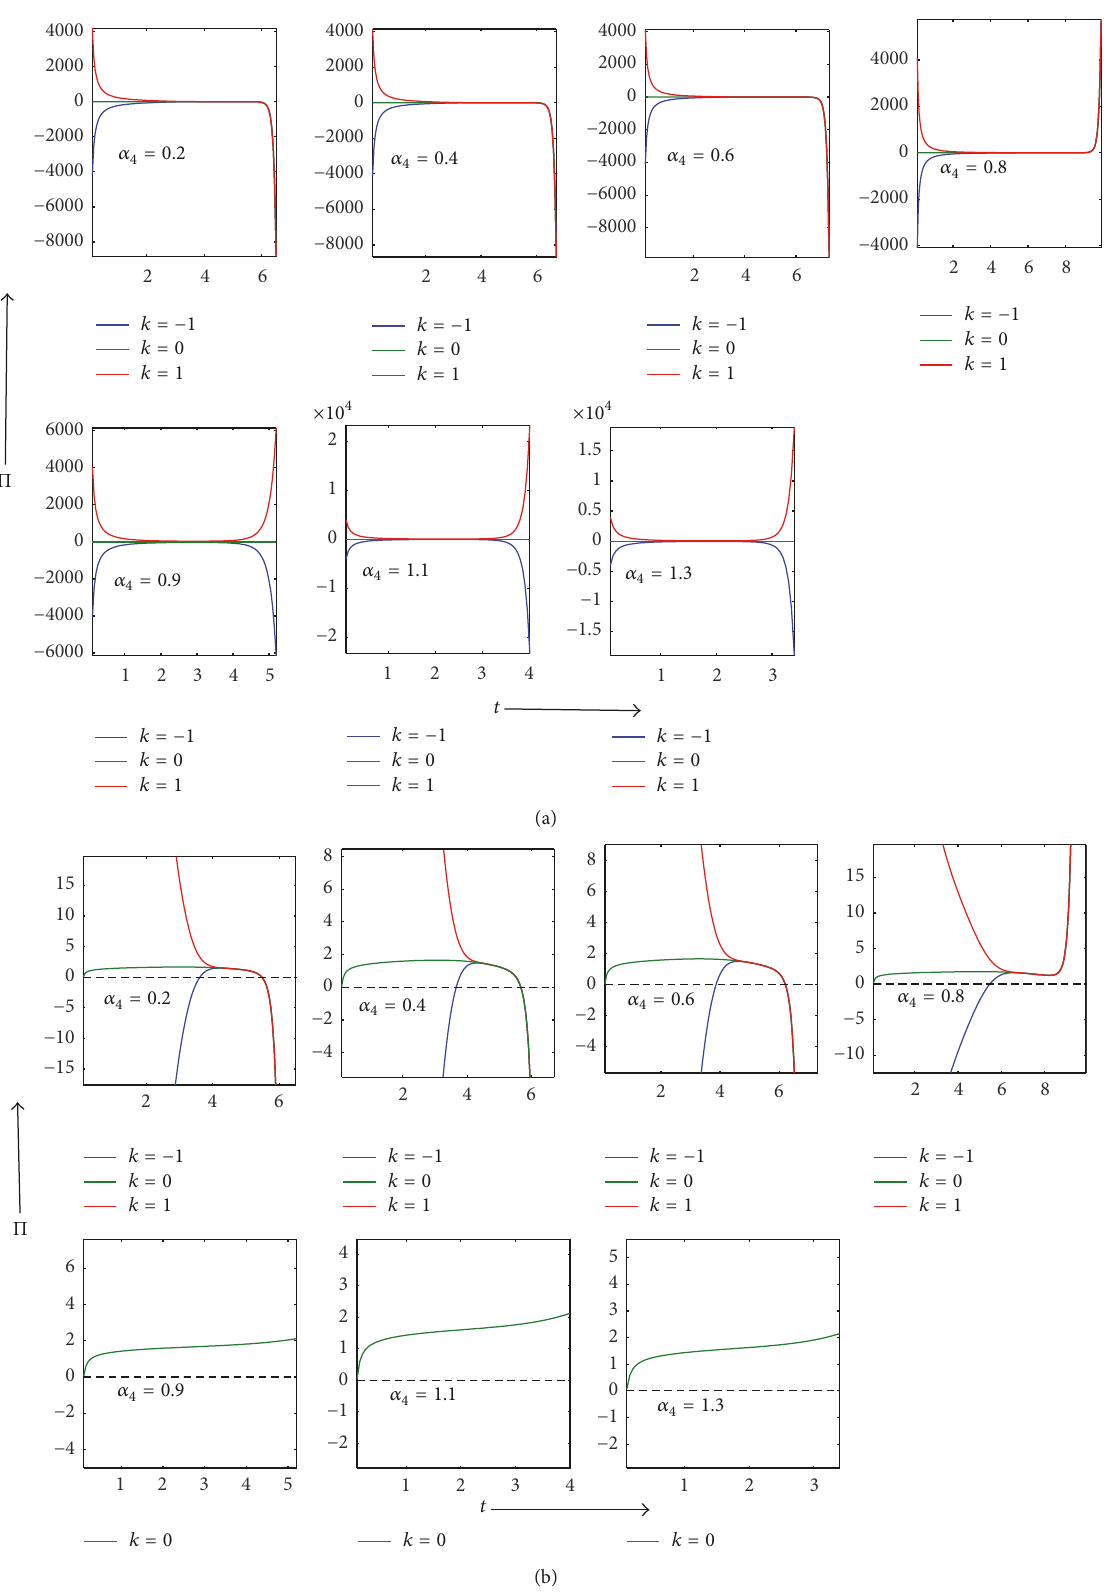
Figure 7: Variation of bulk viscous stress Π against time for 𝛼 1 = 0.5 , 𝛼 2 = 0.5 , 𝐴 = 𝐵 = 1 , 𝑛 = 0.1 , 𝜔 = 1 , 𝜙 0 = 1 , 𝑐 2 = 0.1 , and different 𝛼 4 . (b) shows the zooming of